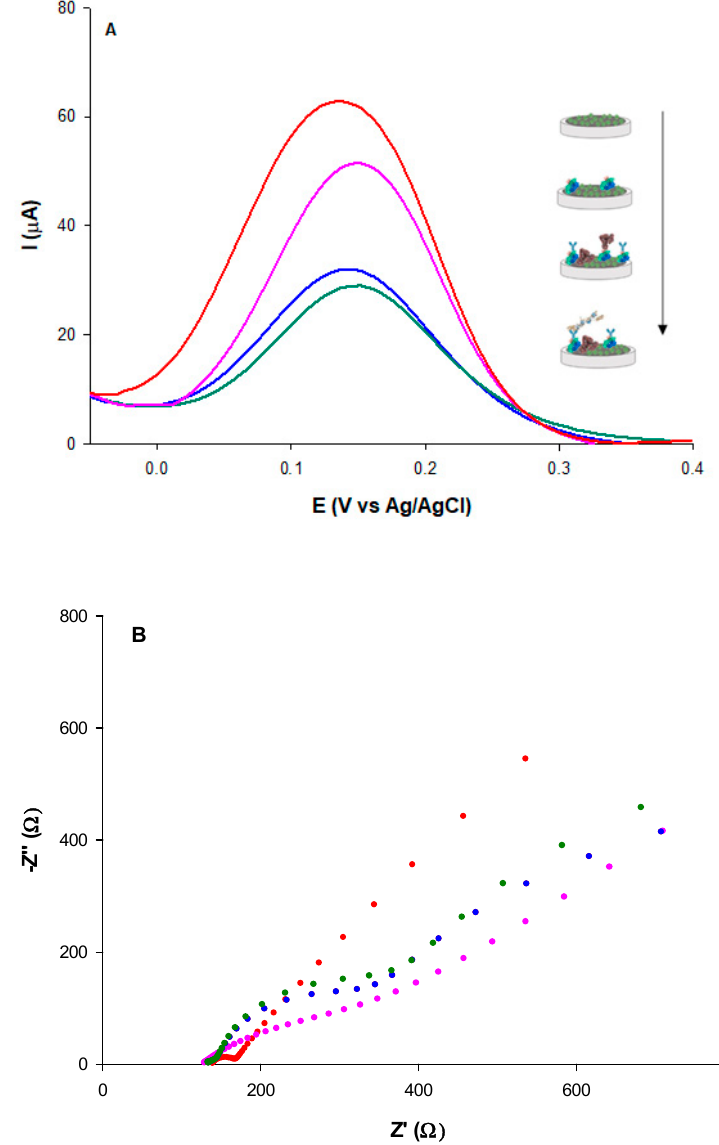
Figure 4. ( A ) DPVs and ( B ) Nyquist plots of: MWCNTs-CSNPs (red), MWCNTs-CSNPs-PrA (pink), MWCNTs-CSNPs-PrA-Ab-BSA (blue), MWCNTs-CSNPs-PrA-Ab-BSA-Ag (dark green) SPEs, mea- sured in Zobell’s solution; D-dimer antigen = 100 µ g L − 1 ; D-dimer antibody = 0.1 µ g mL − 1